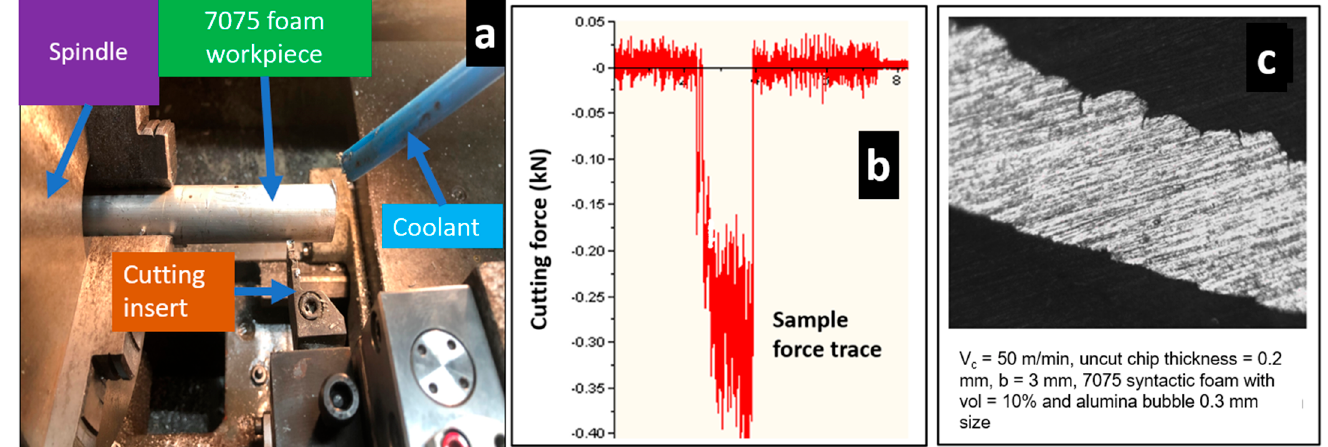
Figure 3. ( a ) Machining experimental test setup; ( b ) Sample force graph taken from dynamometer; ( c ) Representative machined chip for 7075 syntactic foam.